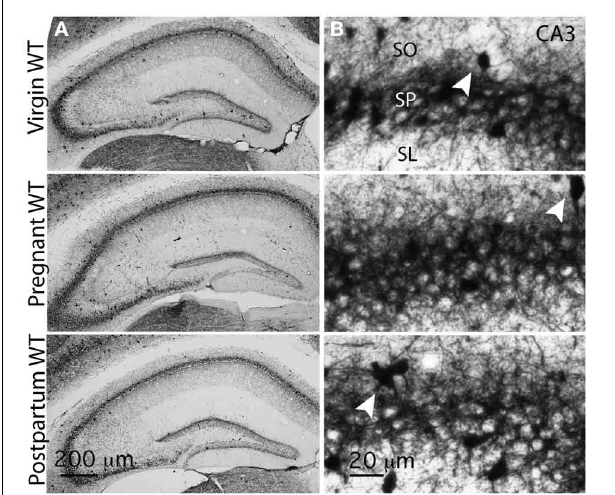
FIGURE 1 | PV distribution remains unchanged throughout the different gestational states. (A) Representative bright-field images of whole hippocampal DAB staining for PV in virgin, pregnant and postpartum WT mice. PV + terminals innervate CA1 and CA3 pyramidal cells and dentate gyrus granule cells, and form a plexus that wraps around their somata and proximal dendrites. (B) Representative high-magnification images of CA3 PV plexus in virgin, pregnant and postpartum WT mice. PV + IN somata are clearly visible within the stratum pyramidale (SP) and in its immediate vicinity (initial portion of stratum oriens SO and stratum lucidum SL), arrowheads. Optical density measurements in CA3 SP show no difference across gestational groups (in arbitrary units AU, mean ± SEM: virgin = 193.6 ± 0.9; pregnant = 192 . 9 ± 1 . 9; postpartum = 196.1 ± 1.7; n = 12, 10, 8 slices and n = 3 mice for each group.). One-Way ANOVA; p = 0 . 32, F ( 2 , 27 ) = 1 .